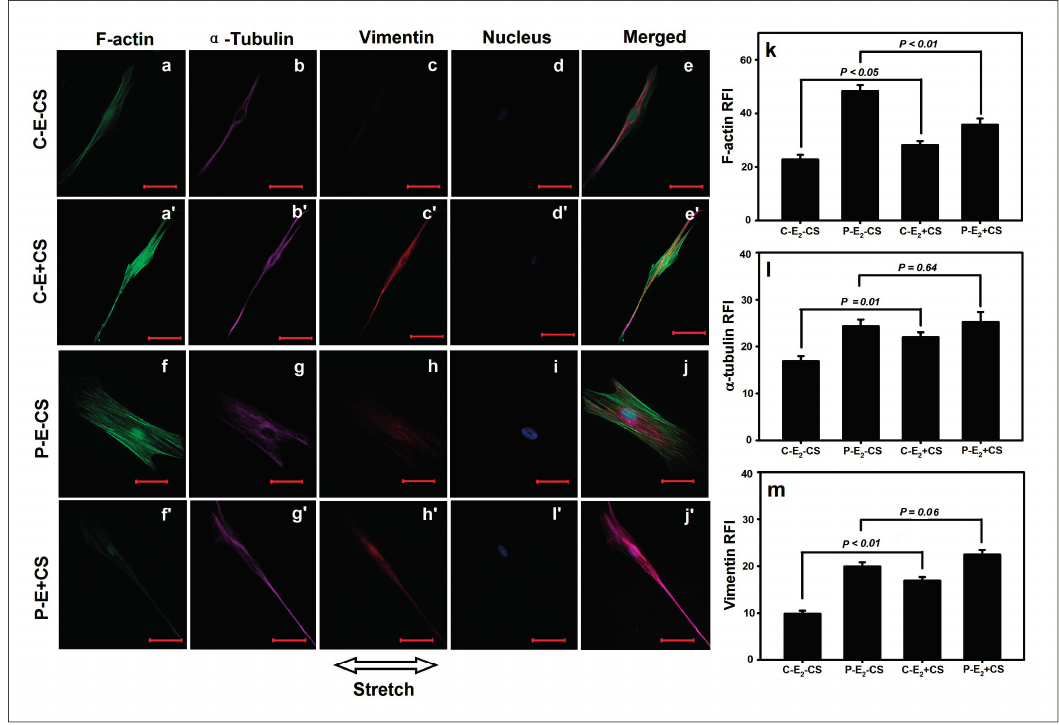
Figure 4. Effects of CS on the cytoskeletons of vaginal fibroblasts. The comparisons in relative fluorescence intensities (RFIs) of the cytoskeletal proteins between the static-cultured fibroblasts and the CS-cultured fibroblasts ( k – m ). Images of the cytoskeletons ( a' – e' and a – e , f' – j' and f – j ). Bar = 50 μ m. The RFIs of F-actin ( k ), α -tubulin ( l ), and vimentin ( m ) were measured and are represented as the mean ± SE from triplicate